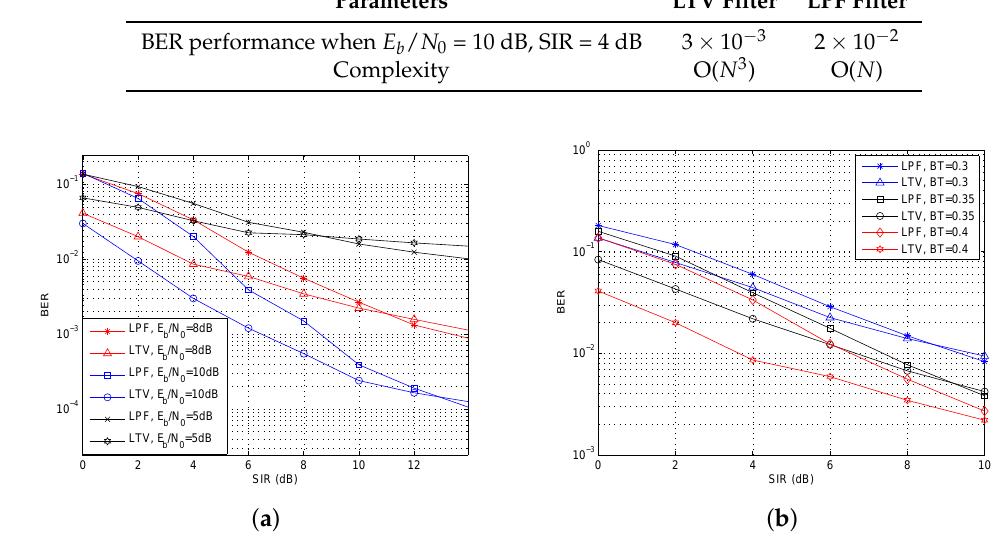
Figure 15. The BER performance with the proposed co-channel interference suppression method. ( a ) BER varies with different SIRs; ( b ) BER varies with SIRs with different